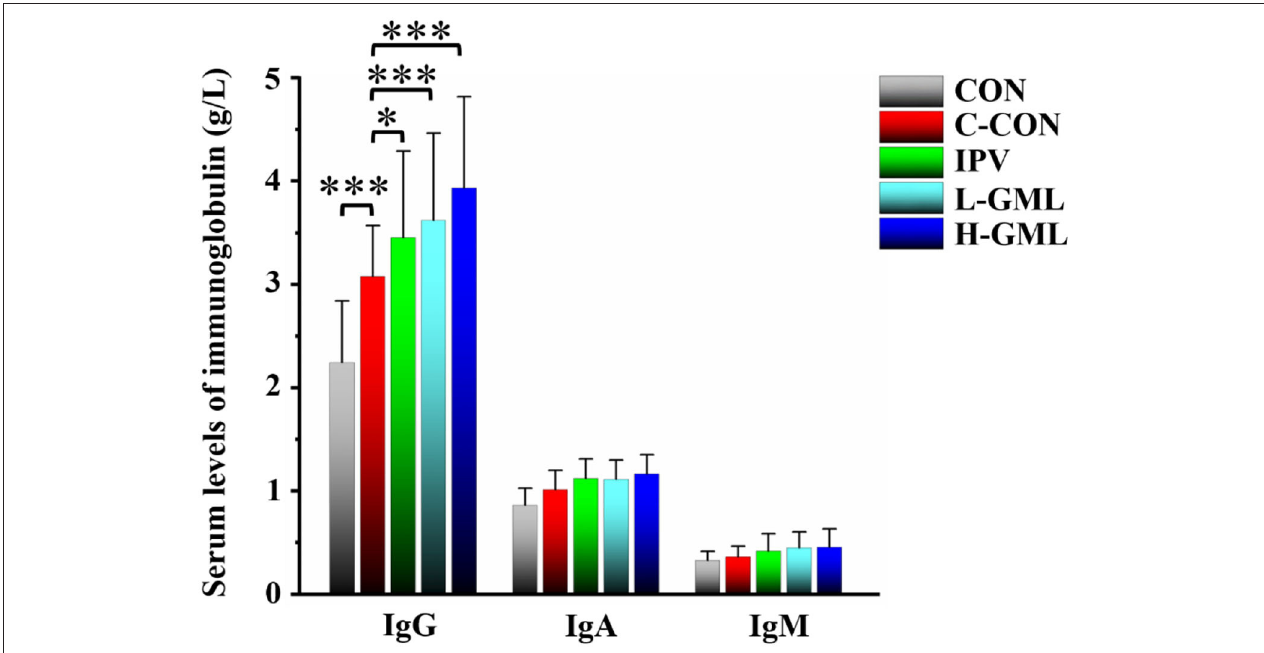
FIGURE 2 | Levels of immunoglobulin G (IgG), immunoglobulin G (IgA), and immunoglobulin G (IgM) in serum of experimental pigs. The results are presented as mean ± SD. Dissimilar numbers of stars represent significant differences (*: p < 0.05, **: p < 0.01, ***: p <